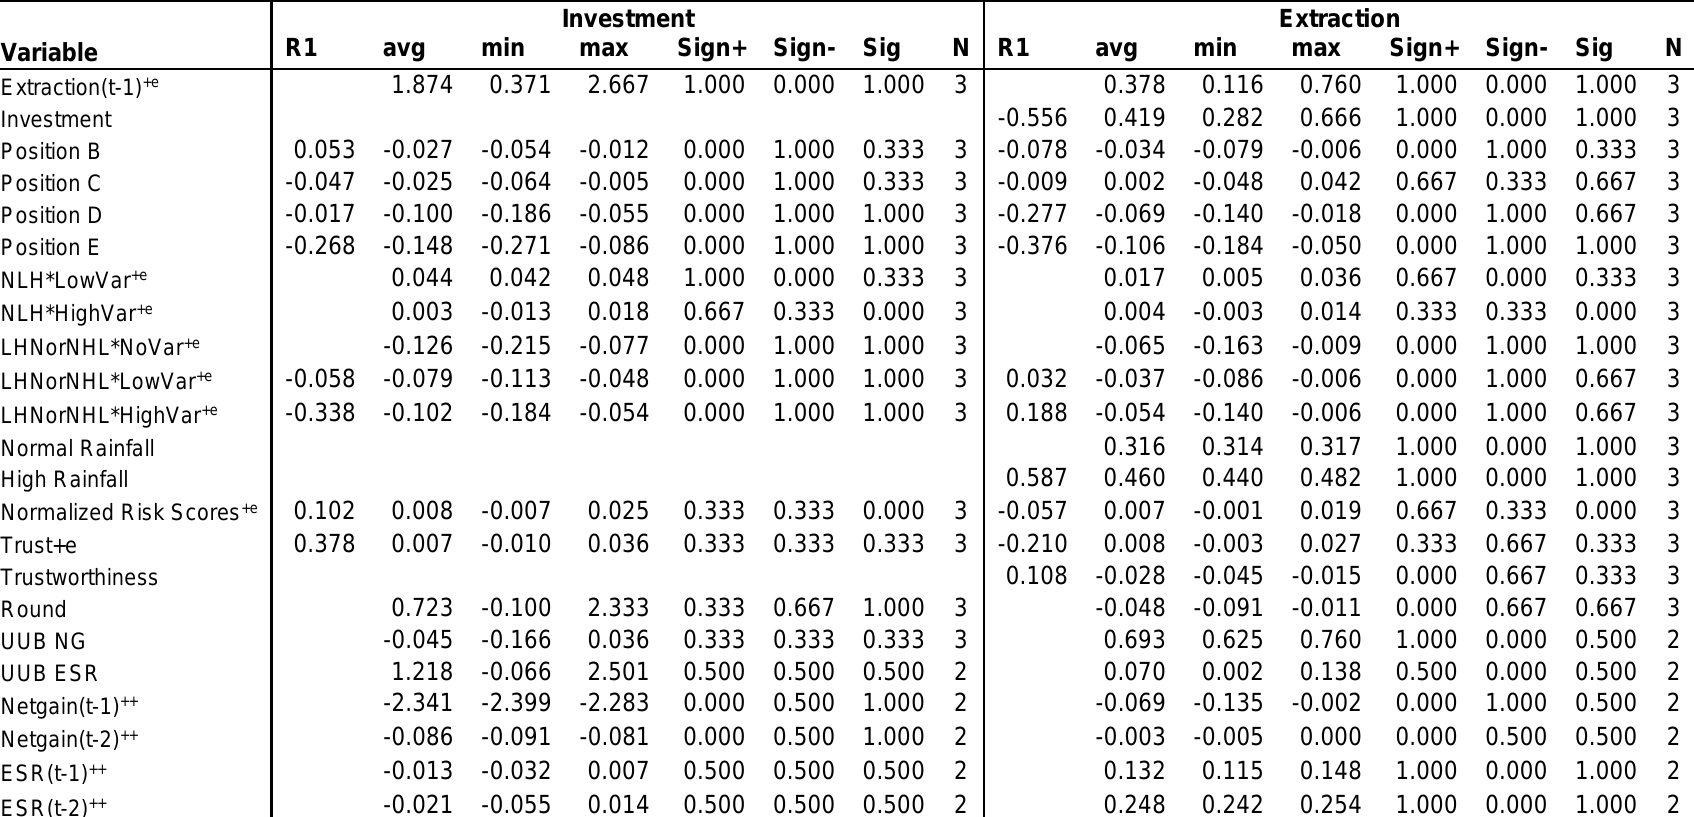
Table S4: Summary for system coefficients at the Individual